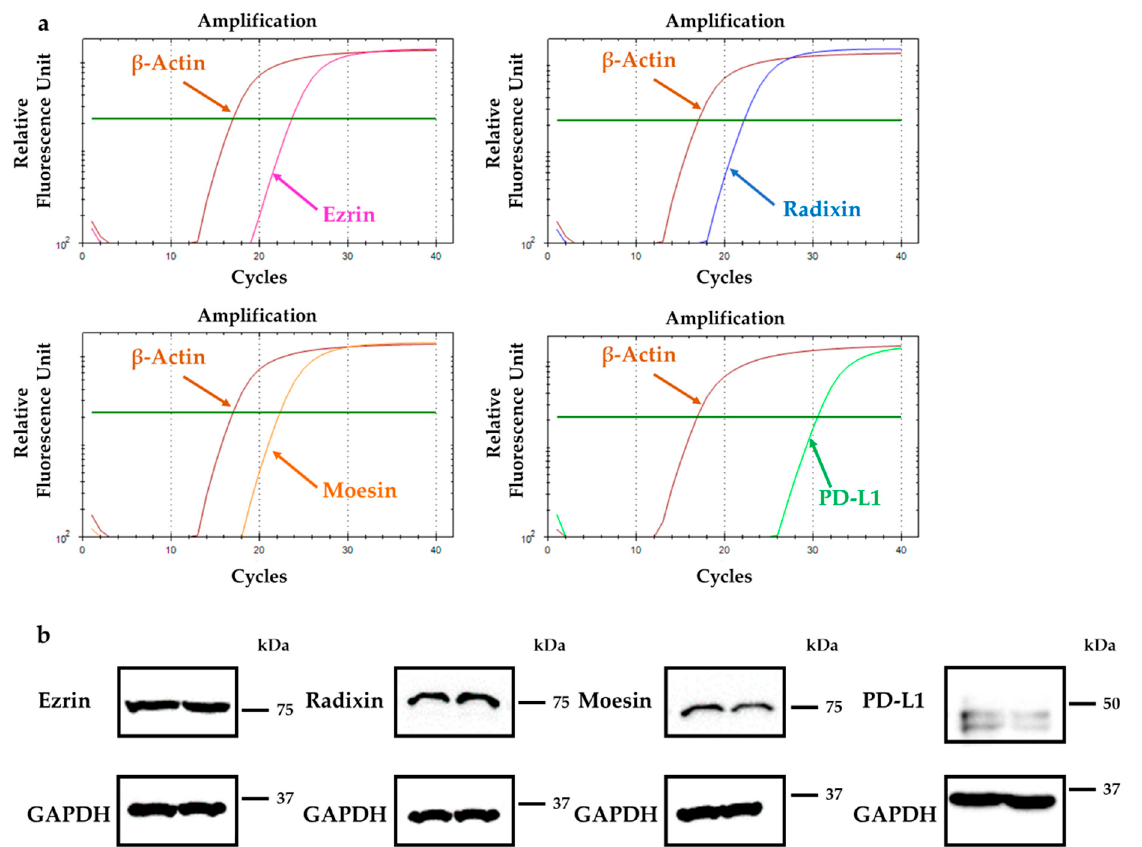
Figure 1. Gene and protein expression patterns of ezrin, radixin, and moesin (ERM), and programmed cell death ligand-1 (PD-L1) in HeLa cells. ( a ) Representative amplification curves for ezrin, radixin, moesin, and PD-L1, together with those for β -actin (internal control), in HeLa cells, as determined with reverse transcription-polymerase chain reaction (RT-PCR). ( b ) Western blot images of each protein in whole-cell lysates of HeLa cells. Upper panels are typical images of ezrin, radixin, moesin, and PD-L1 and lower panels are corresponding glyceraldehyde-3-phosphate dehydrogenase (GAPDH) used as internal control, all of which are shown in duplicate. Molecular weights are indicated in kDa. Data are representative of three independent experiments performed using at least three independent series of total RNA and protein extracts.